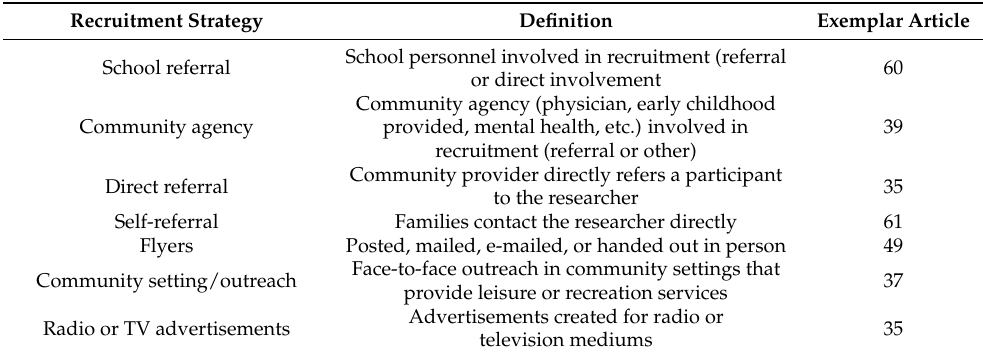
Table 4. Recruitment Strategies Across Research